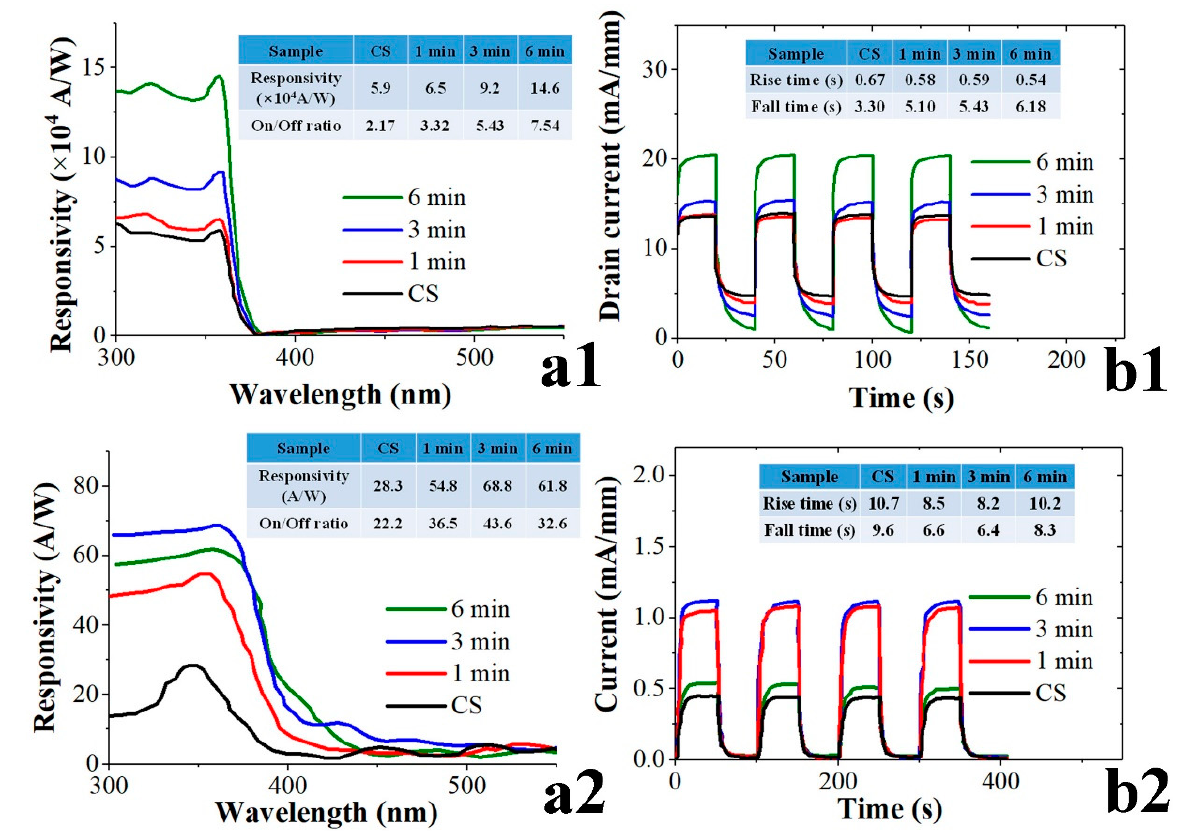
Figure 7. Spectral responsivities and transient characteristics of ( a1 , b1 ) the HEMT-based PDs and ( a2 , b2 ) IDE pattern-based UV PDs fabricated on the PET substrates.